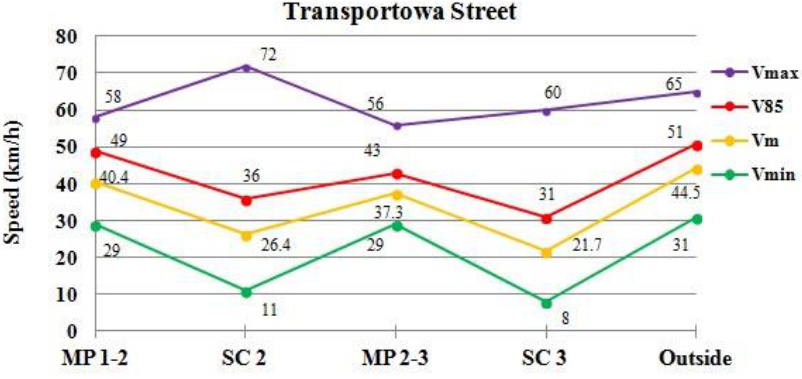
Figure 7. Speed values in the measurement points in Transportowa Street, in Bialystok (Poland).